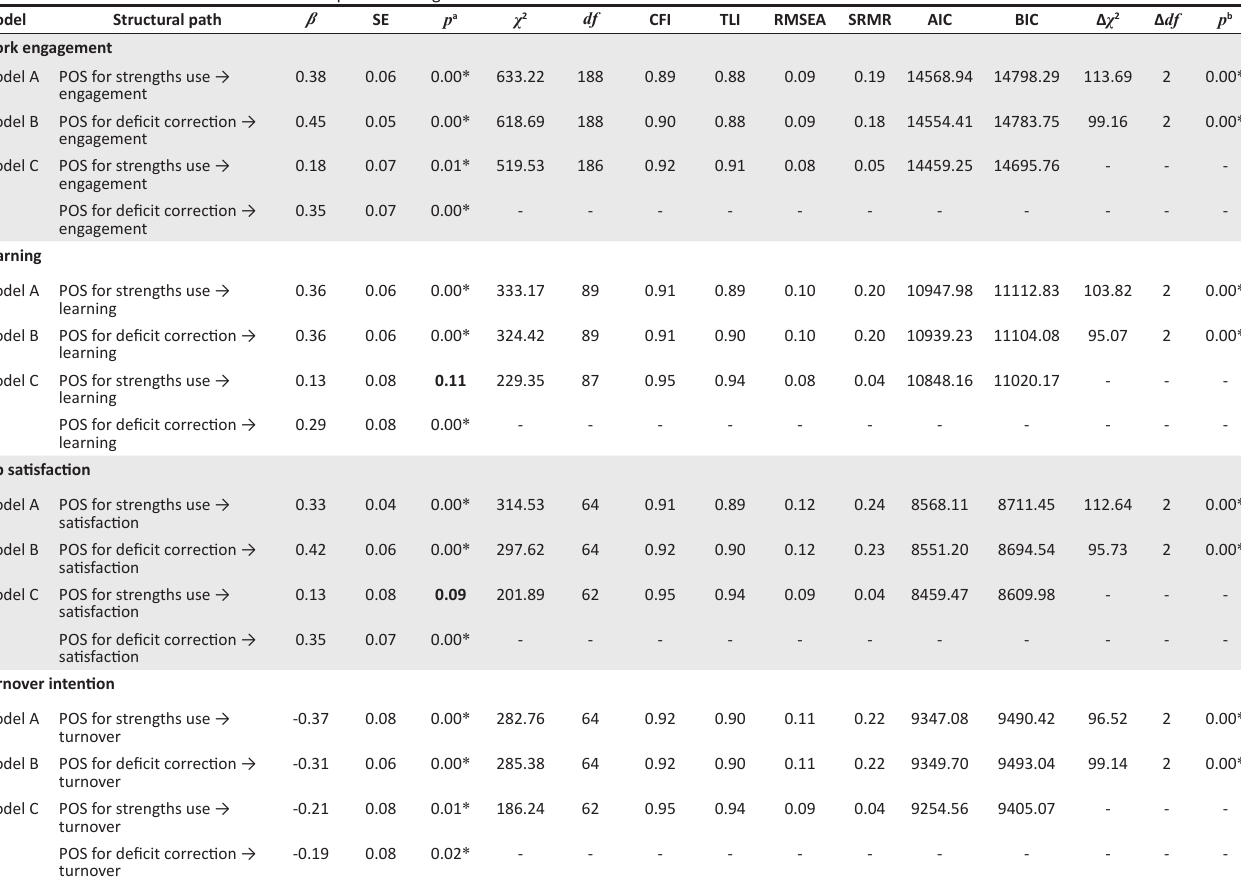
TABLE 3: Goodness of fit indices and structural paths investigated for the different outcome variables.